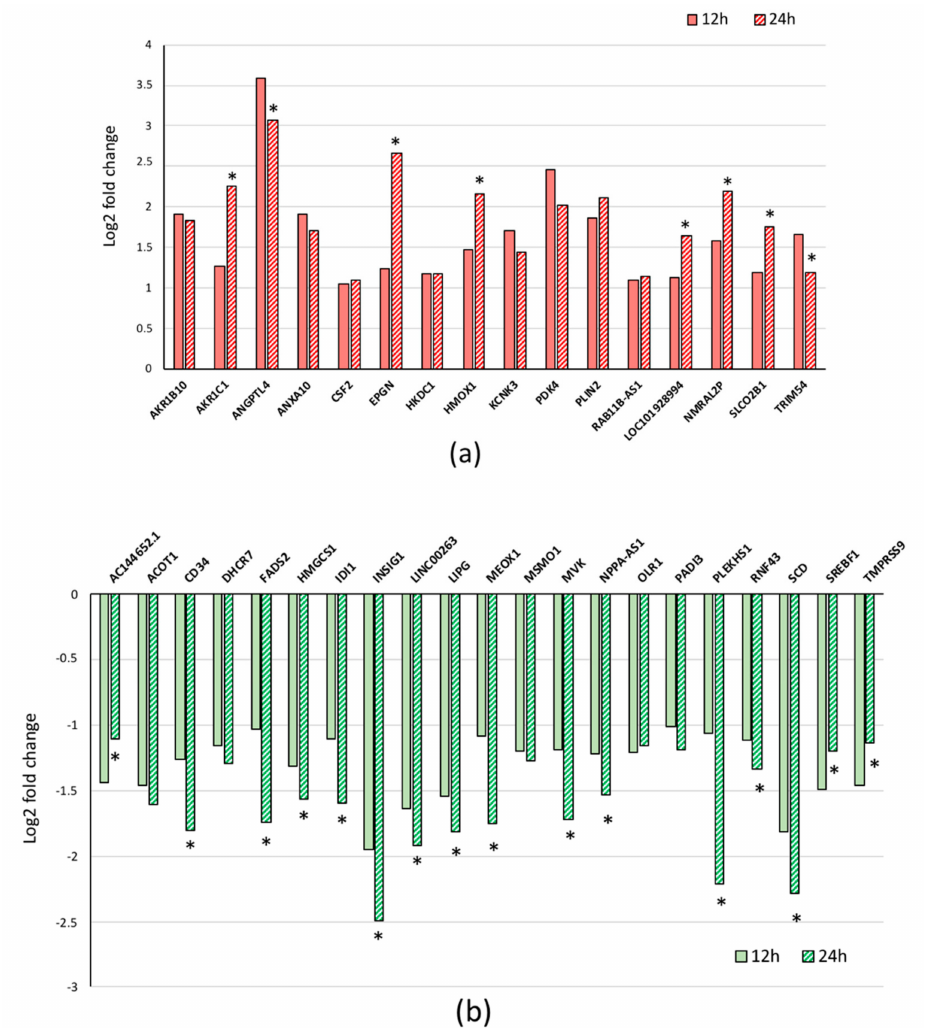
Figure 2. Di ff erentially expressed genes with time-dependent e ff ects of DHA. Log2 fold change of upregulated ( a ) and downregulated ( b ) genes at 12 h and 24 h after DHA treatment. Data were extracted from Tables 1 and 2; the p values between DHA-treated samples and corresponding control samples were below 0.001 (Tables S2 and S3), and the comparison between treated samples at 12 h and 24 h was significantly di ff erent (*) with p <